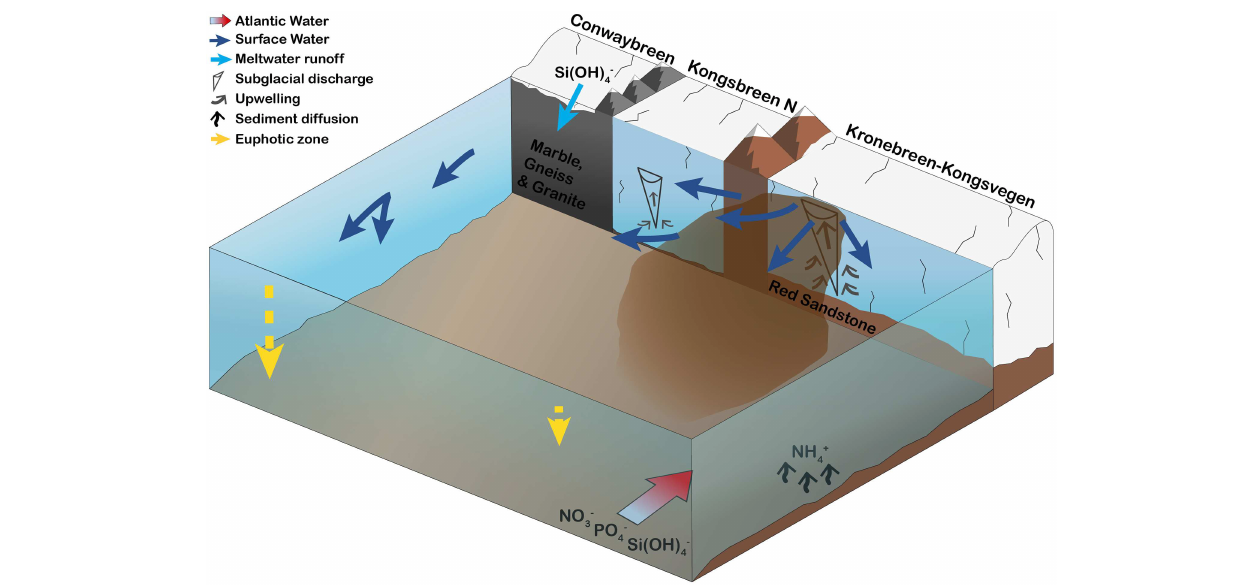
FIGURE 9 | Schematic illustration of the major tidewater glacier and bedrock characteristics that control phytoplankton growth conditions in inner Kongsfjorden during summer. Four tidewater glaciers are surrounding the inner fjord basin: Conwaybreen, Kongsbreen (only northern branch shown), and Kronebreen-Kongsvegen. Conwaybreen grounded at or slightly below the waterline delivers meltwater mainly through surface runoff (riverine discharge) and submarine melting. There, glacier meltwater is rich in silicic acid through glacial-driven bedrock erosion. In contrast, buoyant subglacial discharge plumes at Kronebreen-Kongsvegen and to minor extent also at Kongsbreen North entrain large volumes of ambient, nutrient-rich deeper waters. Thereby, phosphate, nitrate and silicic acid contained within Atlantic Water entering the inner fjord basin along the southern shoreline and ammonium being released locally from the seafloor, are transported to the surface. Differences in meltwater discharge rates and bedrock geology lead to high suspended matter loads in the Southern Glacier Zone and, thus, limiting phytoplankton growth. In the Northern Glacier Zone, lower suspended matter loads and different sediment characteristics create more favourable light conditions (deeper euphotic zone), enabling a flagellate-dominated phytoplankton bloom in 2017. The bloom was likely fuelled by nutrient advection from the southern towards the northern fjord zone.